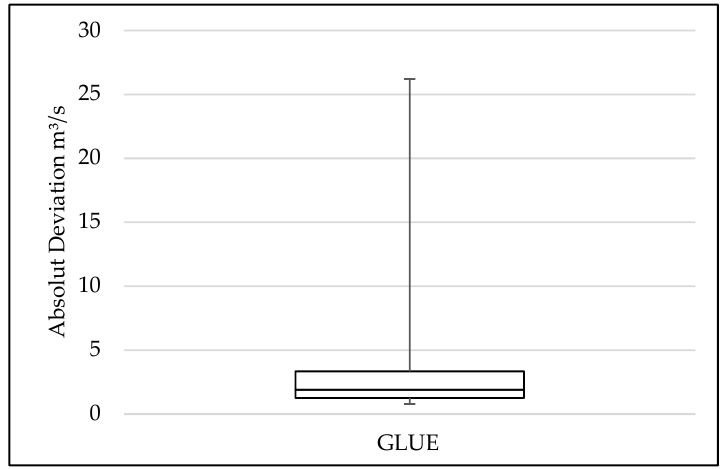
Figure 4. Boxplot of absolute deviation, point the outlier results—GLUE.